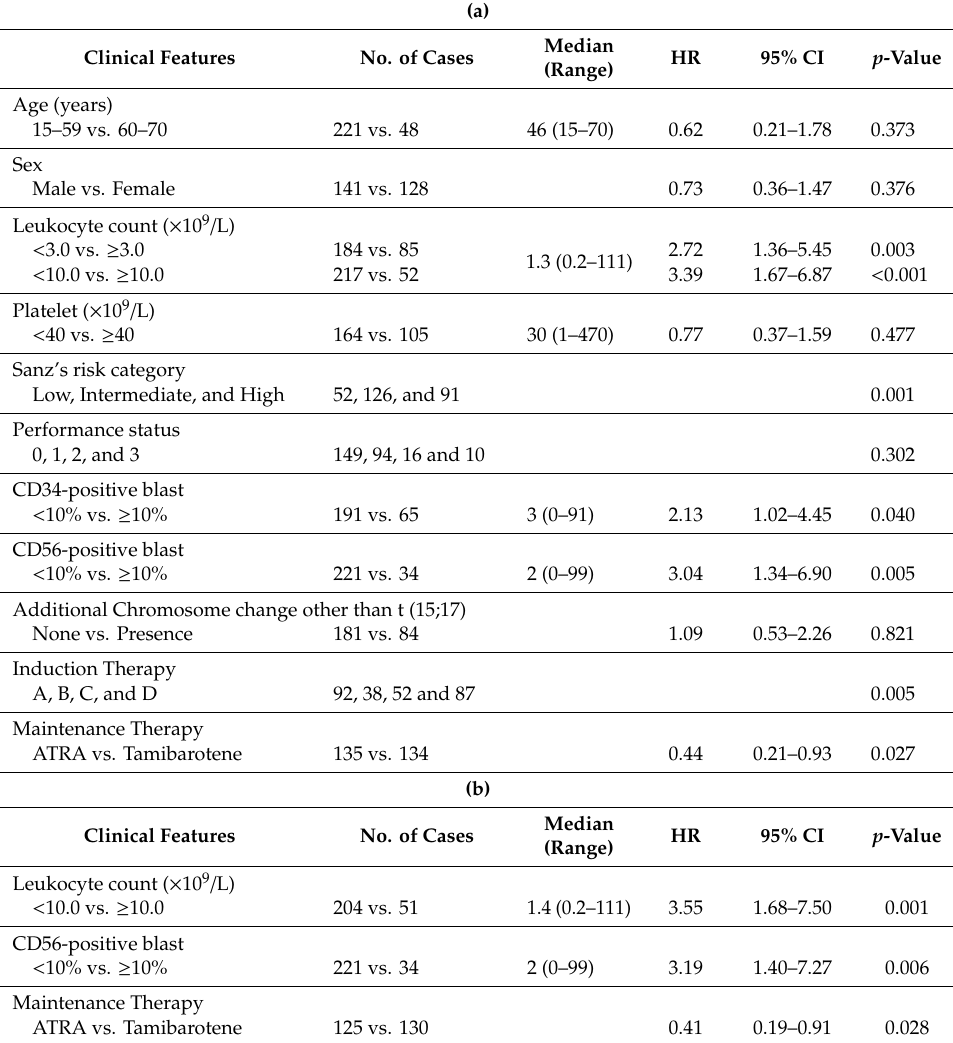
Table 3. ( a ) Univariate analyses for RFS. ( b ) Multivariate analyses for RFS.